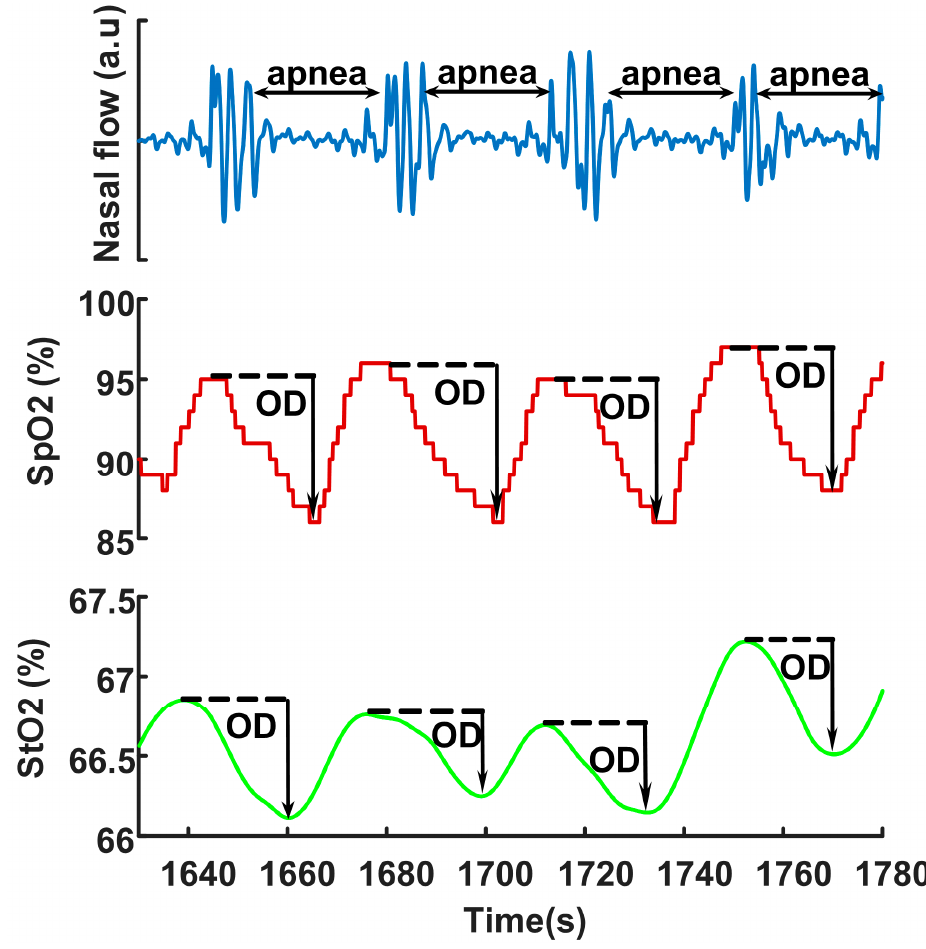
Figure 2. Typical fingertip SpO2 desaturation and arm StO2 desaturation during apneas. The arrow indicates the degree of oxygen desaturation (OD). SpO2 is measured at PSG fingertip by transmission photoplethysmography, and StO2 is measured at biceps muscle by FDMD-NIRS. The results of the final LMMs predicting arm_OD and finger_OD selected by step- wise regressions are shown in Tables 1 and 2, respectively. The conditional R 2 and Ω 2 of